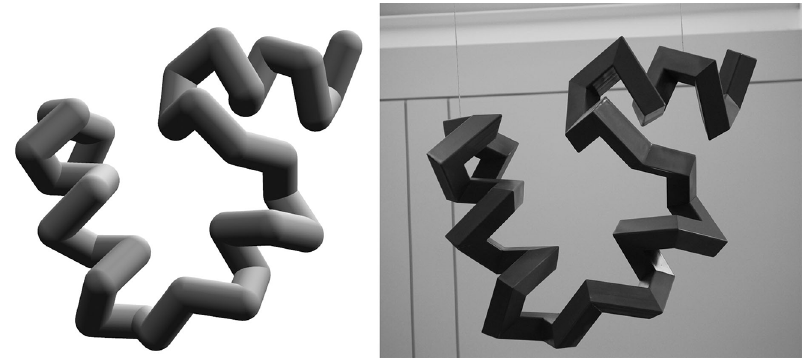
Figure 1. With the students’ help, we transformed atomic coordinates ( left , rendered with UCSF Chimera [ 28 ] ) into remarkably accurate three-dimensional steel sculptures ( right , approximately 1 m in height).